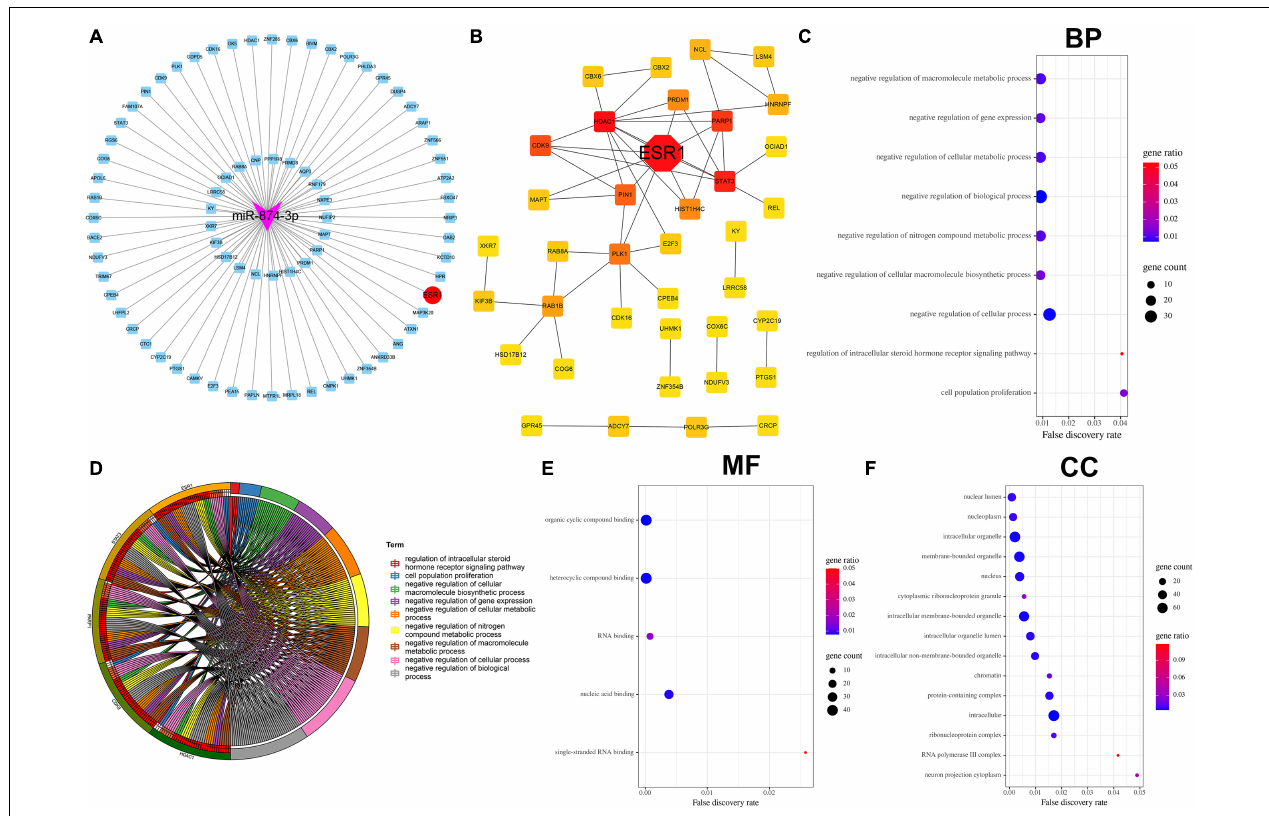
FIGURE 3 | Bioinformatics analysis of miR-874-3p target genes predicted using the miRTarbase database. (A) Cytoscape software was used to visualize the miR-874-3p target genes, of which miR-874-3p and ESR1 were indicated with red ellipse and purple triangles, respectively. (B) ESR1 was identified as a key hub gene in the PPI network using the Cytoscape plug-in cytoHubba, of which ESR1 is indicted with a red diamond. (C–F) GO analysis of miR-874-3p target genes through the STRING website. FDR < 0.05 was regarded as statistically significant. (C) Bubble diagram shows the main biological process. The x -axis represents the FDR, the left y -axis represents the GO terms, and the right y -axis represents the gene ratio (up) and gene count (down). (D) GO chord diagram shows the five hub genes involved in the main biological process. The left outside of the circle represents the genes, whereas the left inside of the circle represents the FDR. (E) Bubble diagram shows the enrichment of molecular function. (F) Enrichment of the cellular component is shown by bubble